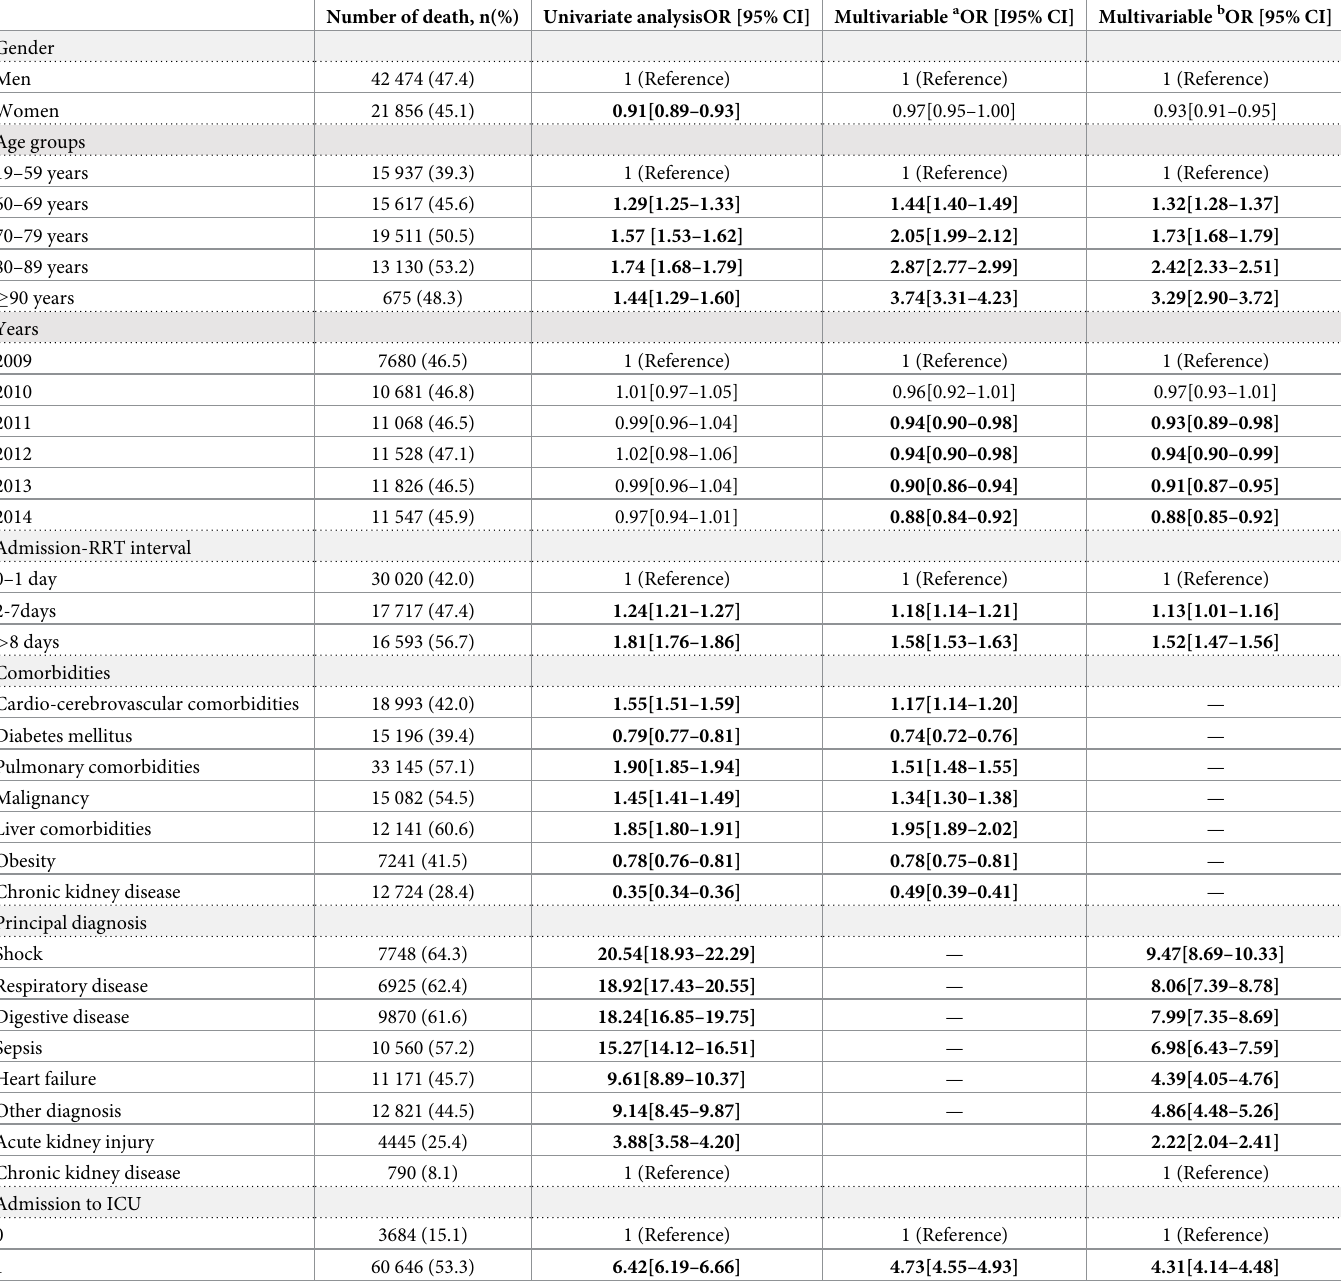
Table 4. Univariate and multivariable analyses of in-hospital mortality in AKI patients requiring